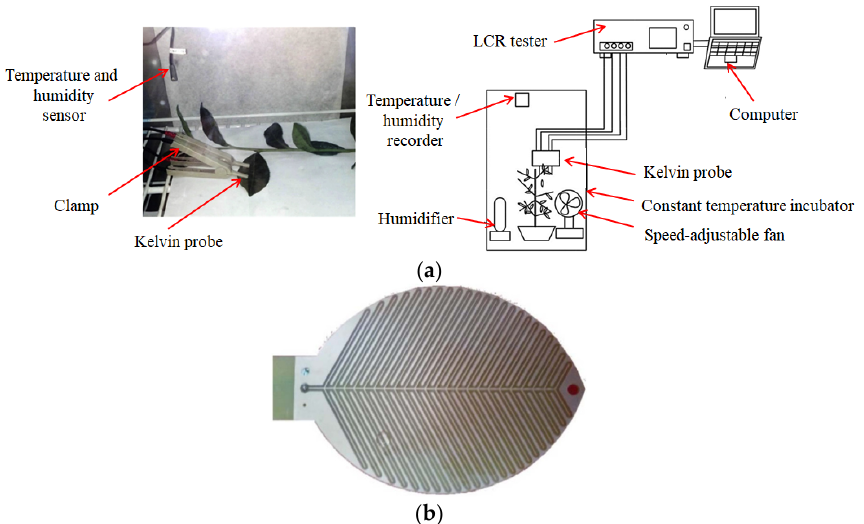
Figure 11. Capacitive frost detection technology: ( a ) testing system of tea leaf electrical property; ( b ) the leaf wetness sensor (LWS) [78]. ( b ) the leaf wetness sensor (LWS)